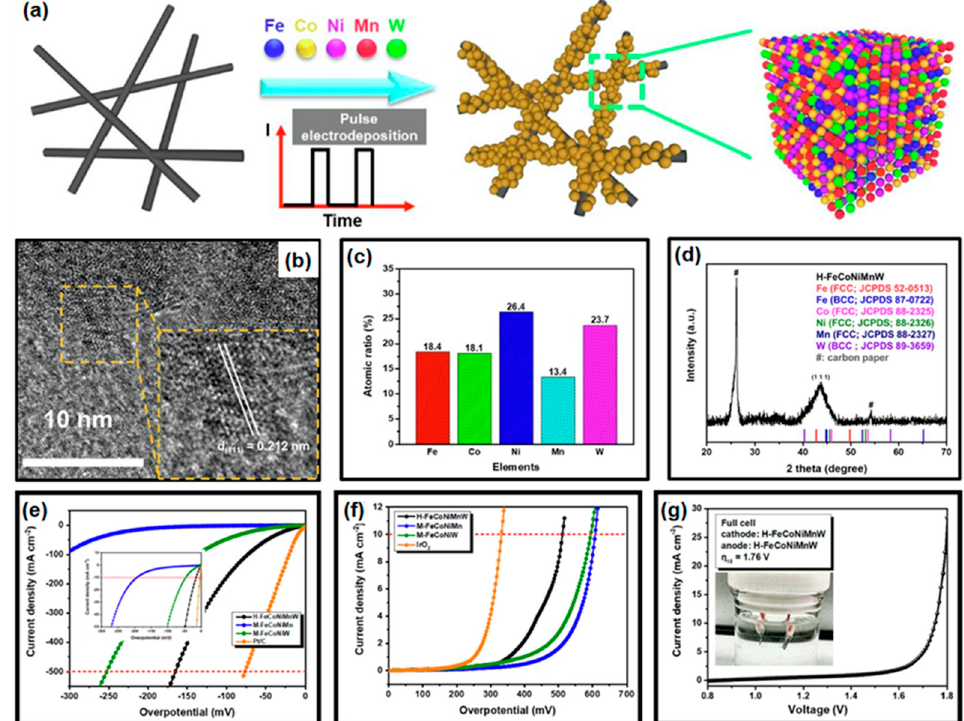
Figure 7. ( a ) Schematic illustration of the synthesis of H-FeCoNiMnW using pulsed mode electro- deposition. ( b ) HR-TEM image of electrodeposited H-FeCoNiMnW powder. ( c ) Atomic composition of H-FeCoNiMnW according to ICP-OES measurement. ( d ) XRD pattern of the synthesized H- FeCoNiMnW. ( e ) Electrocatalytic water-splitting performance of H-FeCoNiMnW, M-FeCoNiMn, and M-FeCoNiW in acidic medium (0.5 M H 2 SO 4 ) ( e ) for HER and ( f ) for OER (H-FeCoNiMnW loading: 8 mg/cm 2 ). ( g ) Overall water-spli tt ing demonstration using H-FeCoNiMnW as both the cathode and the anode at 10 mA/cm 2 (cell voltage: 1.76 V). Reprinted (adapted) from [110], copyright (2023) Else- vier B.V.